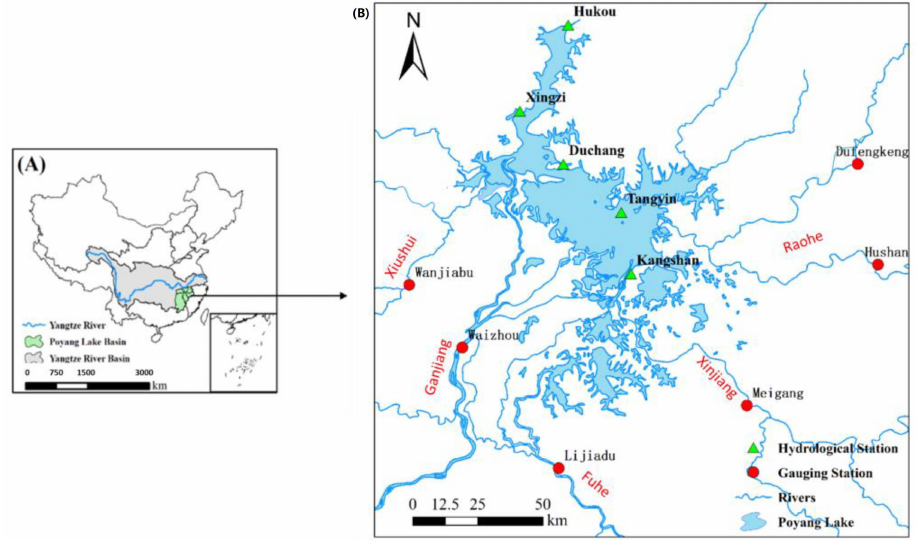
Figure 1. Poyang Lake area ( A ) and rivers, hydrological stations and gauging stations in Poyang Lake ( B ).